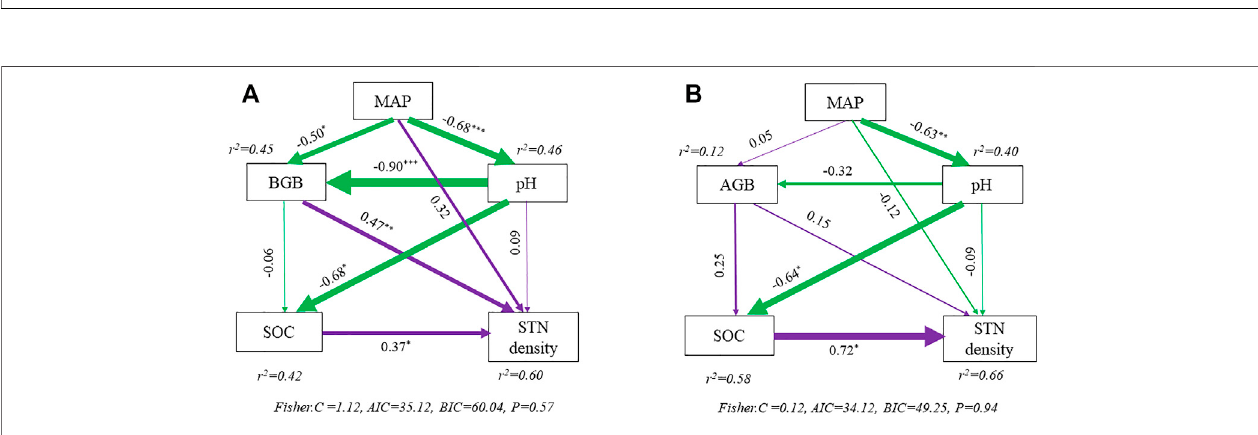
FIGURE5| Partialcorrelationsamongsoilfactors,includingpHandSOC,climaticandvegetationfactorsinalpinewetlandsandalpinemeadow.Thenumbersand color indicated the strength of correlation coef fi cient. Signi fi cant association was estimated at the level of 0.05 and was marked as *. MAP, mean annual precipitation; AGB, aboveground biomass; BGB, belowground biomass; SOC, soil organic carbon density; pH = soil pH.